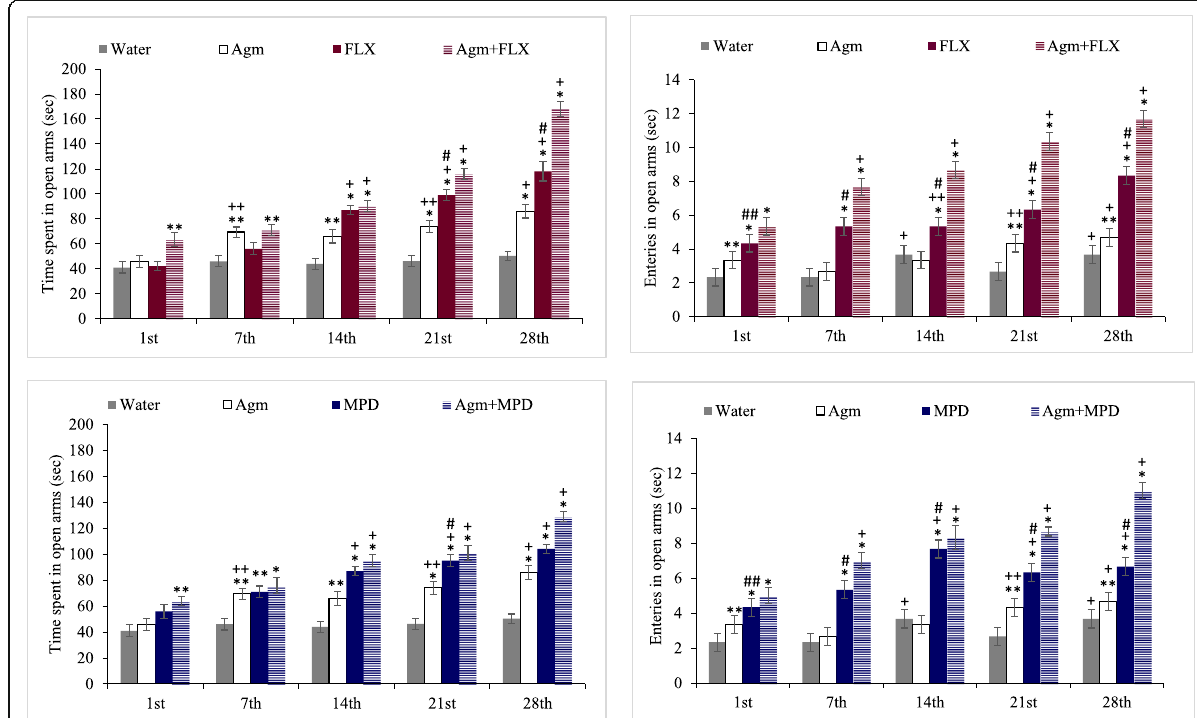
Fig. 6 a EPM (time spent): values are expressed as means ± SD ( n =6). Significant differences by Newman-Keuls test: * p <0.01, ** p <0.05 from water-treated control group to drug-treated groups. + p <0.01, ++ p <0.05 from drug ’ s 1st administration. # p <0.01, ## p <0.05 from AGM-treated animals to FLX- and MPD-treated animals following two-way ANOVA. b EPM (entries): values are expressed as means ± SD ( n =6). Significant differences by Newman-Keuls test: * p <0.01, ** p <0.05 from water-treated control group to drug-treated groups. + p <0.01, ++ p <0.05 from drug ’ s 1st administration. # p <0.01, ## p <0.05 from AGM-treated animals to FLX- and MPD-treated animals following two-way